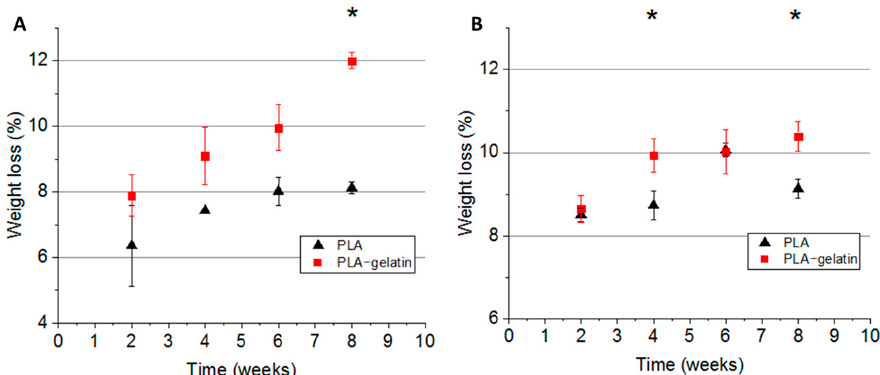
Figure 4. Degradation rate (weight loss over time) of electrospun PLA and PLA–gelatin (9:1) mats over 8 weeks of incubation in PBS ( A ) and in Fenton’s reagent ( B ) at 37 °C. The asterisk (*) marks statistically significant differences ( p < 0.05) between PLA and PLA–gelatin samples according to Student’s t -test.